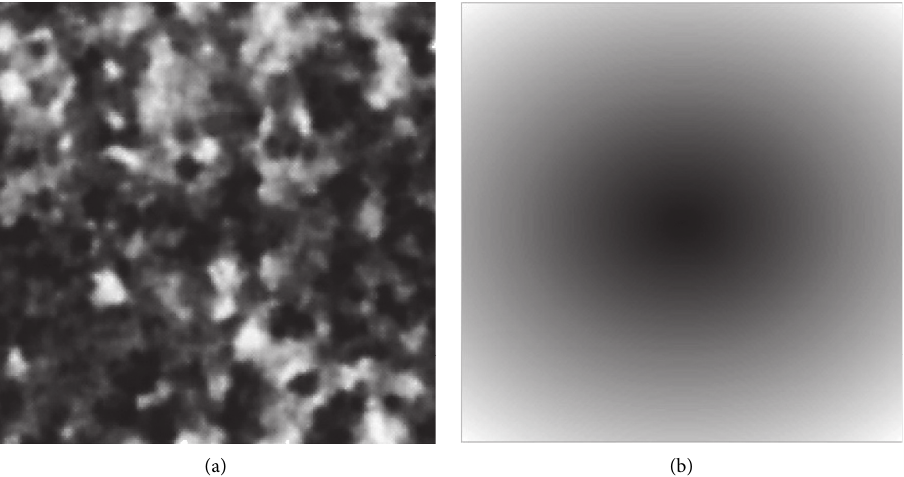
Figure 1: Influencing factors of urban land development (darker color means higher value). (a) Attractiveness. (b) Land price.